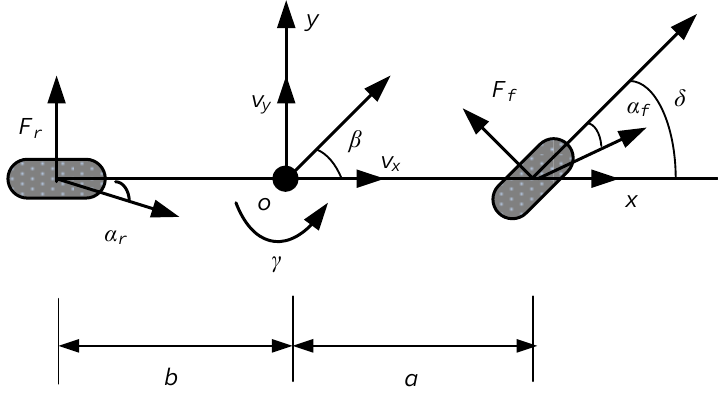
Figure 1. Three-degrees-of-freedom vehicle model.